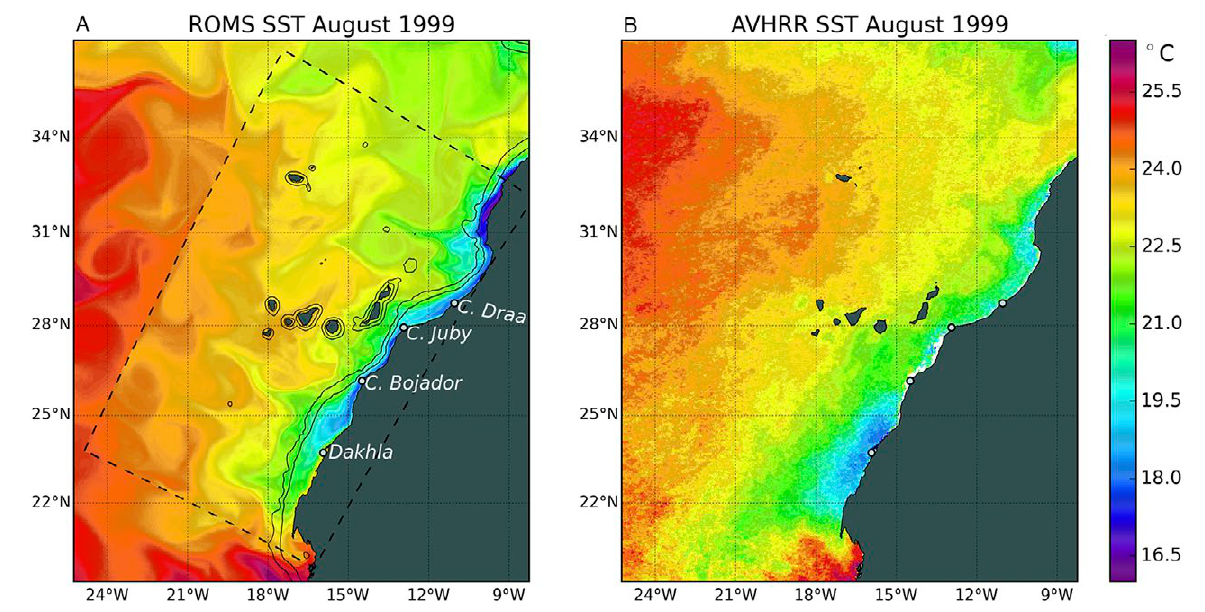
Fig. 2. – Monthly mean SST for August 1999 over the Canary Island region from ROMS (A), and AVHRR V5.2 (B). Dashed lines in A mark the ROMS model domain used for the analysis in Figure 3. Black contours in A correspond to the respective model grid topographies at 200 and 1000